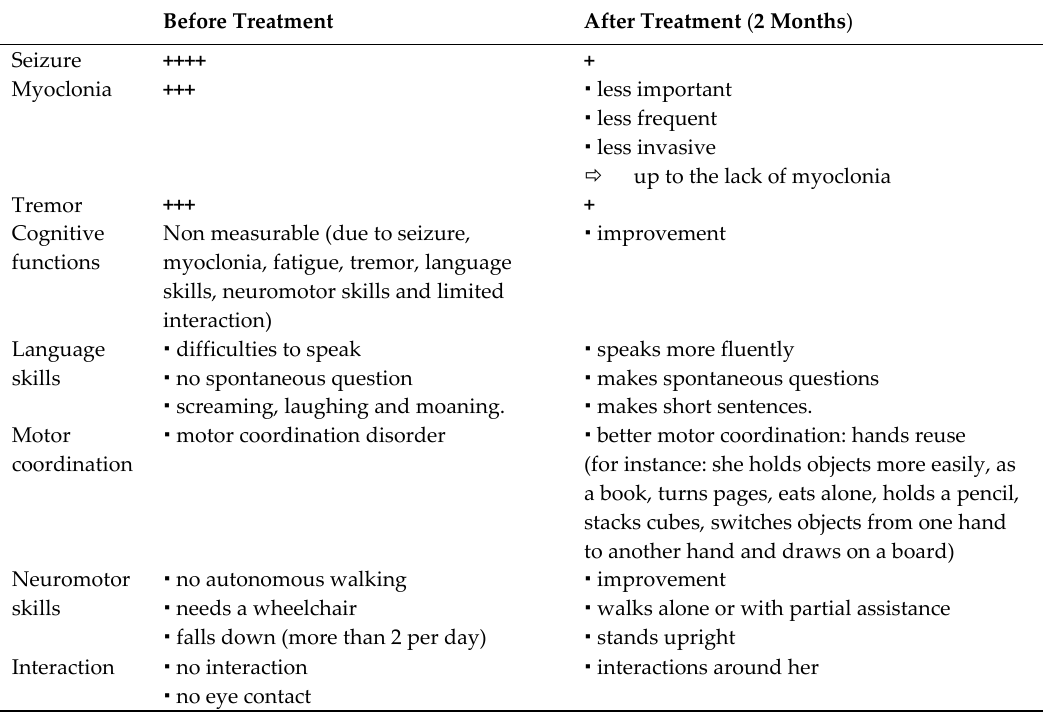
Table 4. Clinical improvement with folinic acid treatment (based on usual clinical exam).